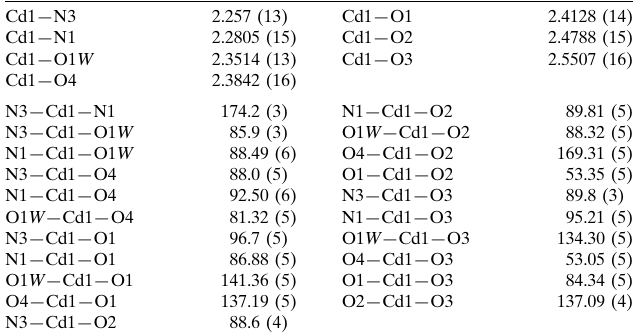
For related literature, see: Song et al. (2007).